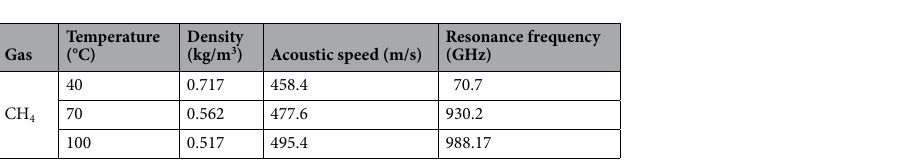
Table 3. The acoustic properties of CH 4 gas and Fano resonance frequency values at 40, 70, and 100 °C.